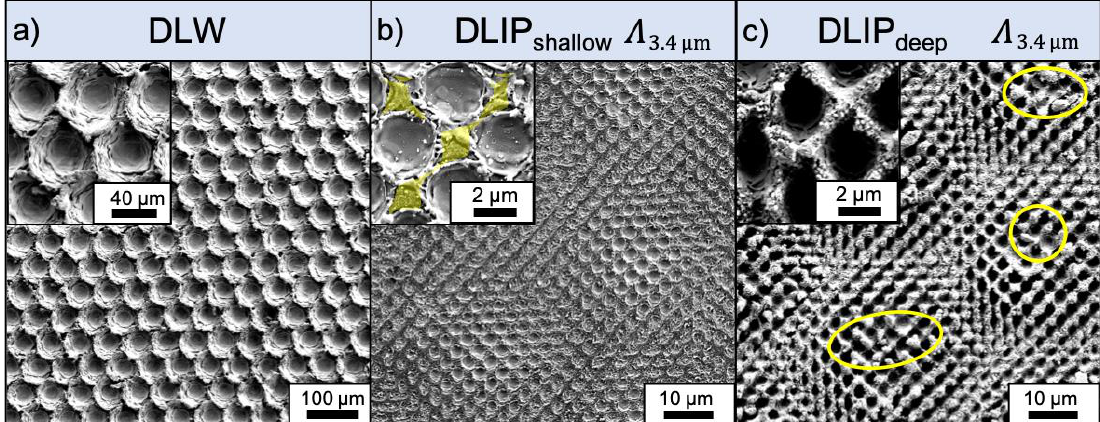
Figure 2. SEM images of the single-scale DLW and DLIP textures with a spatial period of 60 µm and 3.4 µm, respectively. The hexagonally arranged dot-like DLW textures were fabricated using a laser fluence of 6.56 J/cm 2 , 20 pulses per dot and a repetition rate of 30 kHz. The pulse duration of the laser was 14 ns and the used wavelength was 1064 nm ( a ). The DLIP shallow texture was fabricated using 2 pulses per DLIP area and a laser fluence of 0.82 J/cm 2 ( b ), the DLIP deep texture was fabricated using 15 pulses per DLIP area and a laser fluence of 1.33 J/cm 2 ( c ). The laser wavelength, the pulse duration and the repetition rate were kept constant at 532 nm, 70 ps, and 30 kHz, respectively.